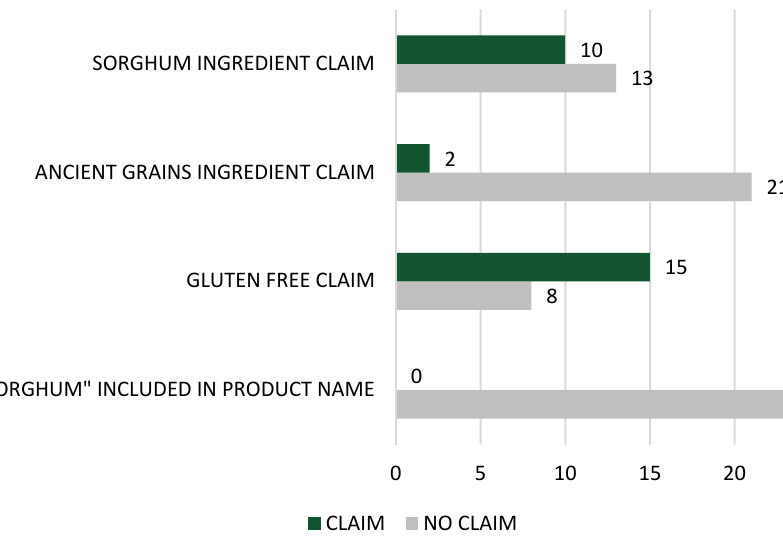
Figure 1. Key front-of-pack claims from sorghum-containing breakfast cereals.